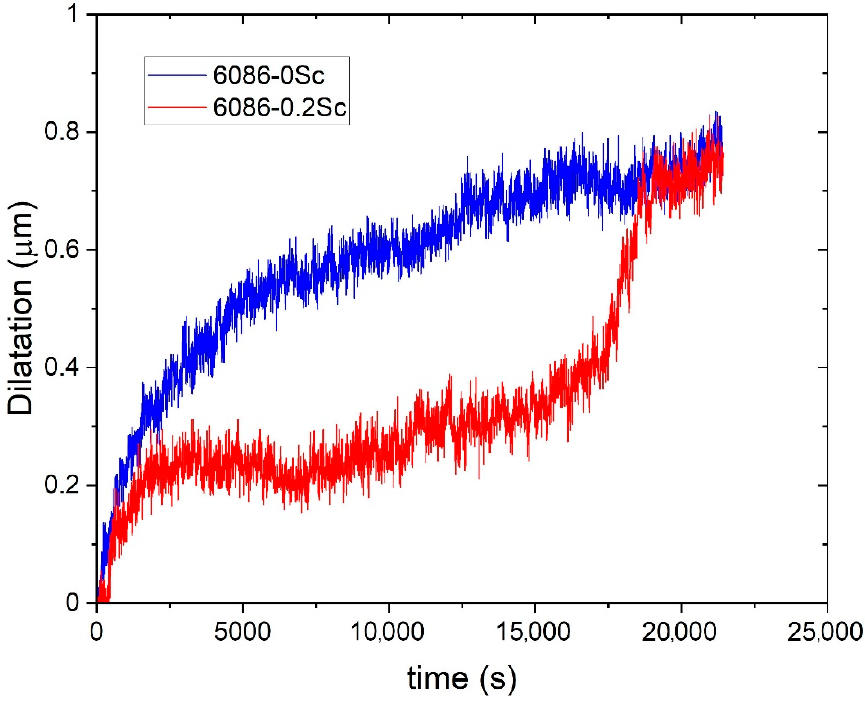
Figure 16. Change in dimensions during isothermal holding at 180 °C after quenching from 520 °C.